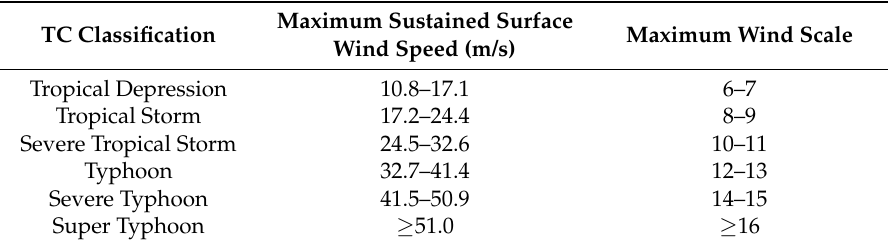
Table 1. Different TC categories based on the maximum wind scale and maximum sustained surface wind